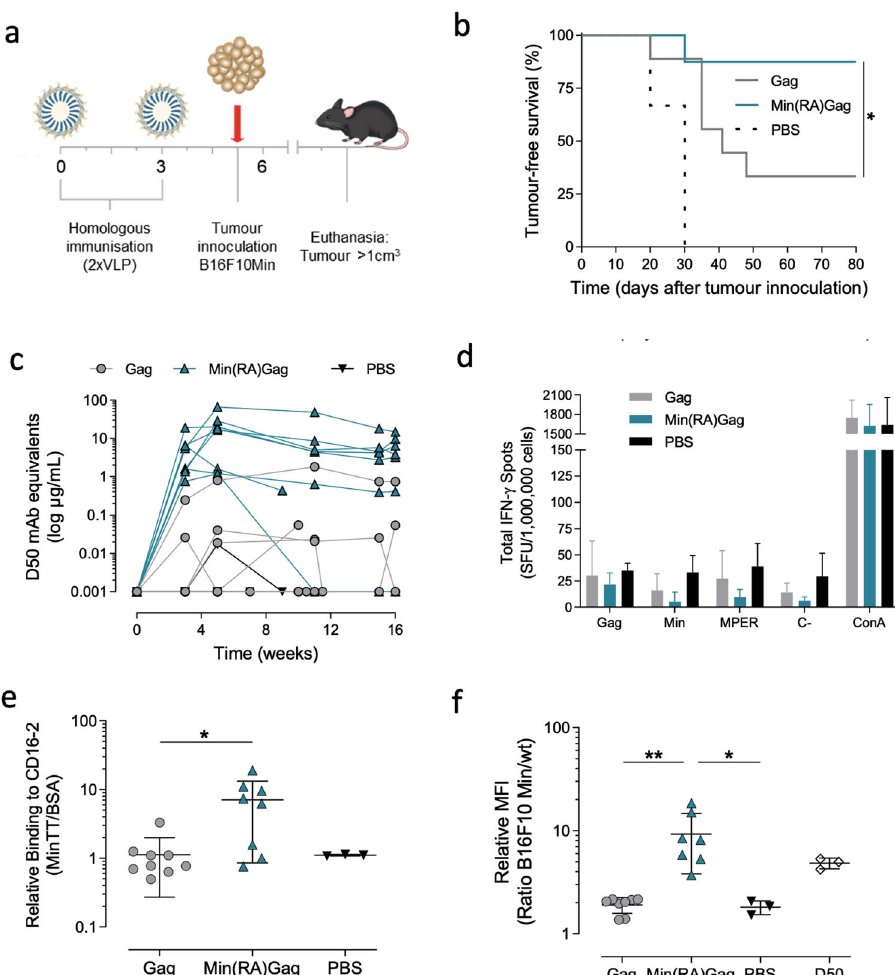
Fig. 6 In vivo protection assay to identify vaccine-induced protection. a Schematic representation of the experimental model. C57BL/ 6JOlaHsd mice were immunised twice with Gag-VLPs (grey rounds; n = 9), Min(RA)Gag-VLPs (blue triangles; n = 8), or PBS controls (black inverted triangles; n = 3) at weeks 0 and 3. At week 5, animals were inoculated with a 100,000 B16F10Min cells and followed up for a period of 80 days after tumour inoculation. b Kaplan – Meier curves of tumour-free survival in VLP vaccinated and tumour-inoculated mice. Animals were euthanised for humane criteria when the tumour reached a size bigger than 1000 mm 3 . Signi fi cance was detected between Gag-VLP and Min(RA)Gag-VLP groups with a Mantel – Cox test (* p = 0.0414). c Anti-Min IgG concentration in the serum of VLP-immunised and tumour- inoculated mice determined by ELISA. d Cellular immune response against pools of Gag, Min, and MPER using splenocytes from vaccinated and tumour-inoculated mice and collected at endpoint. Data represented as mean ± SD. No signi fi cant differences were found in panels c – e between vaccinated groups using a Kruskal – Wallis test. e Relative binding to Fc γ RIV/CD16-2 of anti-Min antibodies referred to a BSA control. Serum was collected at week 5. Data represented as mean ± SD. Signi fi cant differences were found with a Kruskal – Wallis test